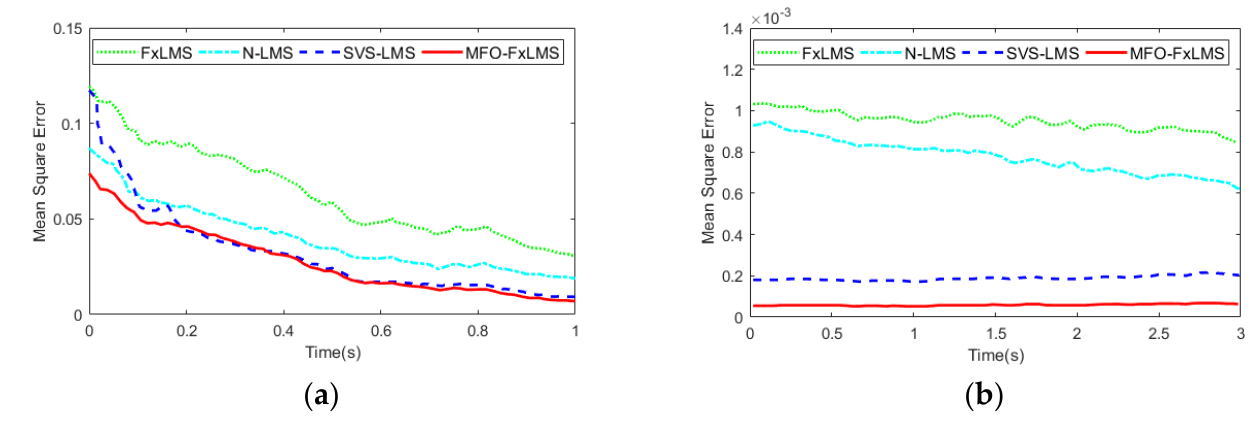
Figure 3. Comparison of mean square error of the four algorithms: ( a ) Early stage of error dynamic convergence; ( b ) Error convergence steady state.